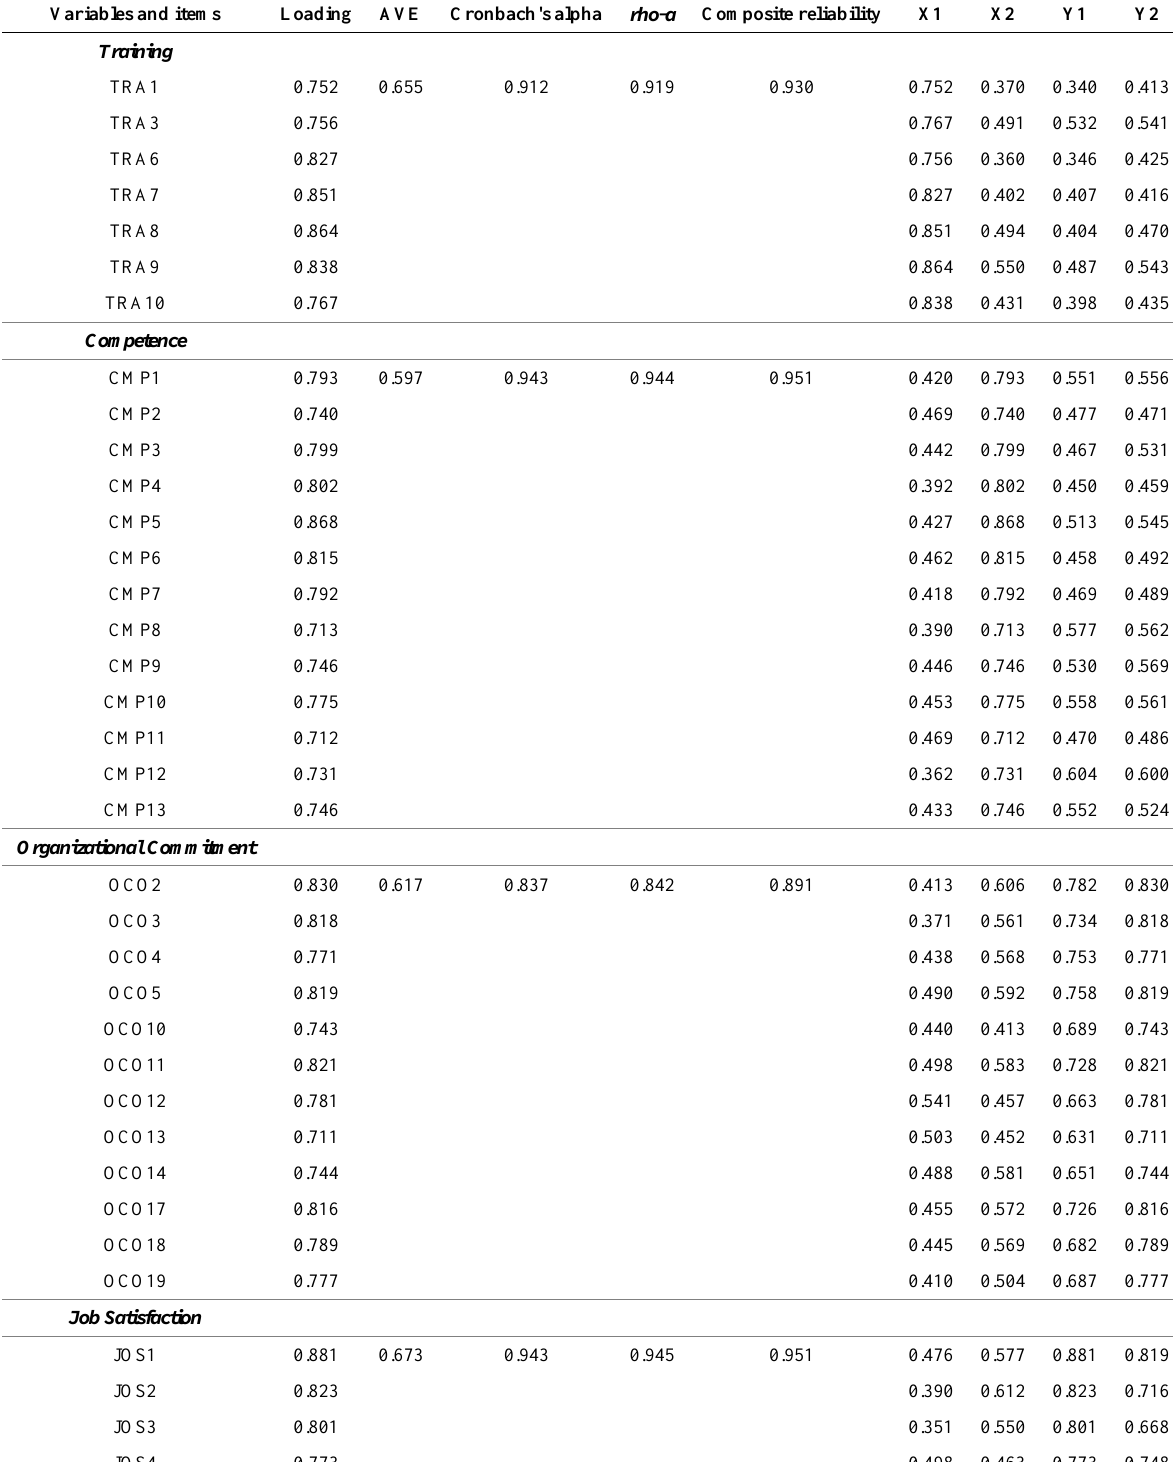
Table 1. Summary of Measurement Model Results